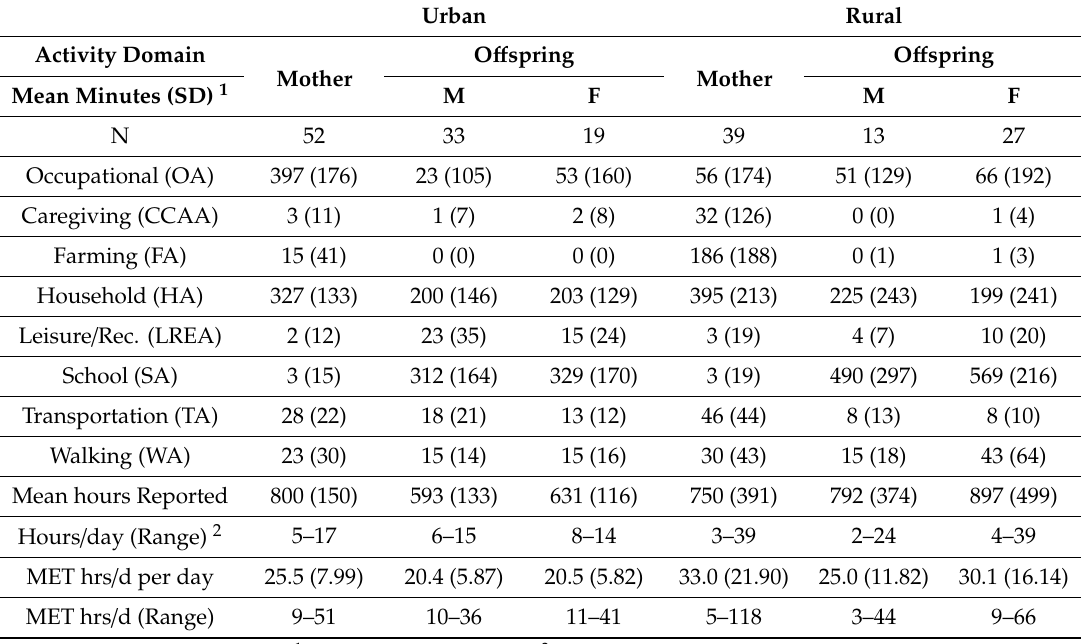
Table 4. Reported time spent in di ff erent activity domains by Chinese parents and o ff spring based on the Chinese Children and Families Cohort Study Physical Activity Questionnaire. Urban